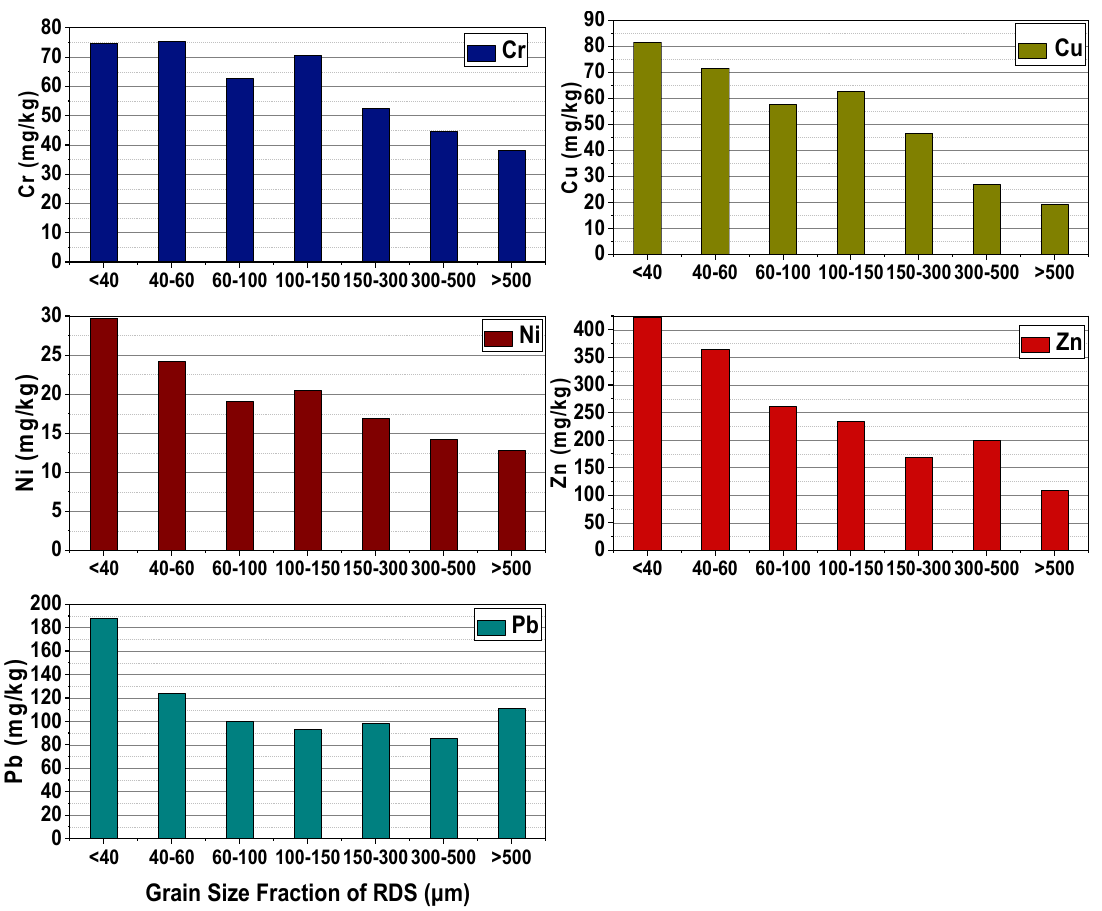
Figure 2. Heavy metal concentrations in RDS.